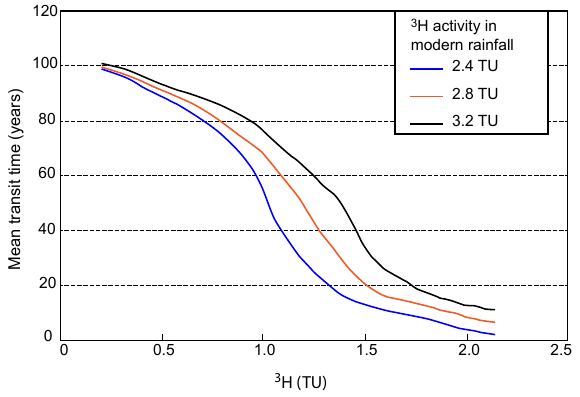
Figure 9. Impact of varying rainfall 3 H inputs on MTTs calculated using the EPM model with an EPM ratio of 1.0. The three rainfall inputs modern and pre bomb-pulse 3 H activities of 2.4, 2.8, and 3.2TU and the 3 H activity of the bomb-pulse rainfall was varied by a similar proportion as discussed in the text.